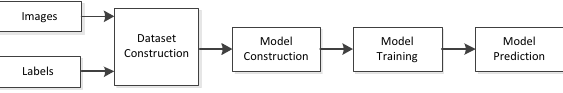
Figure 4. Experimental Process